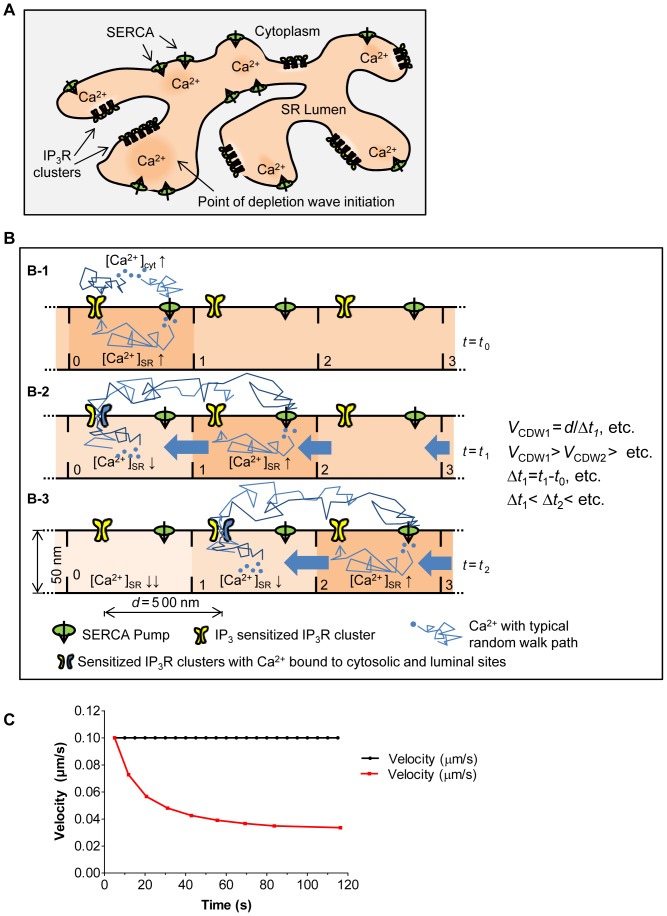
Simplified quantitative model for propagation of SR Ca2+ depletion waves.
A) Schematic model of SR network depicting differential distribution of SR luminal Ca2+ sources (SERCA) and sinks (IP3Rs). B) We represent a linear section of SR as a series of compartments (labelled 0, 1, 2, etc), between which Ca2+ transport is allowed. Panels B-1, B-2, & B-3 represent the same portion of model SR at three different times, t0, t1 and t2. A wave initiating at compartment 0 in this model would move both left and right, but we focus only of the right-moving part for simplicity. Assuming that the [IP3]cyt is such that the IP3R is already Ca2+-sensitized, a [Ca2+]i fluctuation near the SR compartment 0 at t = t
0 raises the [Ca2+]SR from a resting level to a threshold level, and thereby, causes the observed transient rise (B-1). This rise is followed by depletion of Ca2+ from compartment 0. Partial equilibration of luminal Ca2+ then takes place (blue block arrows between compartments), accompanied by an increase in [Ca2+]SR in compartment 1 (B-2). Subsequently, [Ca2+]SR in compartment 1 reaches a threshold value leading to the releases of (some of) its Ca2+, which goes on to partially refill its nearest neighbouring locus (compartment 2), and so on (B-3). Ca2+ release from compartment 1 can trigger release from compartment 2, only after [Ca2+]SR will have reached a critical level for Ca2+ release, which will take a time interval Δt
2 = t2−t1. Due to the Ca2+ passage from compartment 2 to 1, Δt
2 must be greater than Δt1, the interval it took to raise [Ca2+]SR in 1 to the release level. Successive compartment refilling times to release level will get progressively longer because of the ability to re-equilibrate Ca2+ depletions. Assuming now that the CICR sustaining IP3R clusters are on average equidistant at a length d (500 nm) from one another, the Ca2+ depletion wave velocity (v
CDW), as the wave reaches successive compartments, is given by V
CDW1
v
CDW1 = d/Δt1> v
CDW2> …>etc. Under the conditions of the reported experiments, disallowing Ca2+ communication between SR compartments in this model would translate in an equal interval Δt between the wave arrival at each compartment, and therefore in a constant wave velocity (v
CDW = d/Δt). C) Ca2+ depletion wave velocity vs. time calculated from our model, considering Ca2+ communicating (solid curve) or Ca2+ tight (dashed) SR compartments.